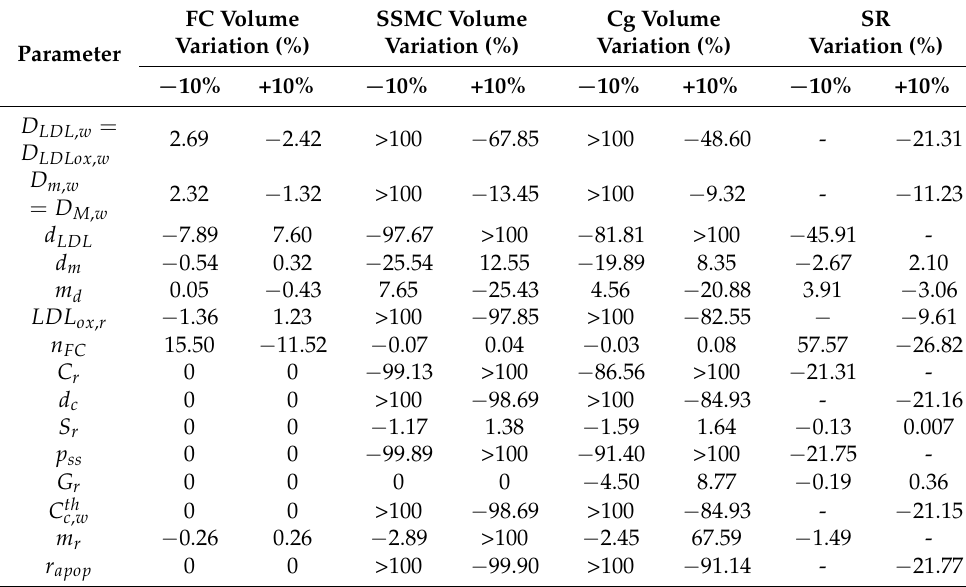
Table 7. Results of the foam cells, synthetic smooth muscle cells, and collagen volume variations (second, third, and fourth columns, respectively), and variation in the stenosis ratio (fifth column), reducing and increasing the values of the parameters of the first column by